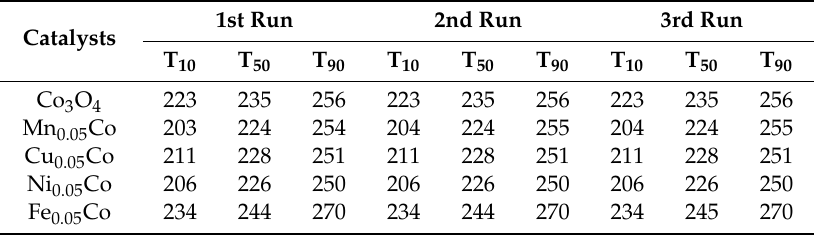
Table 3. Light-o ff temperatures at 10, 50, and 90% toluene conversion upon the cooling process. Catalysts